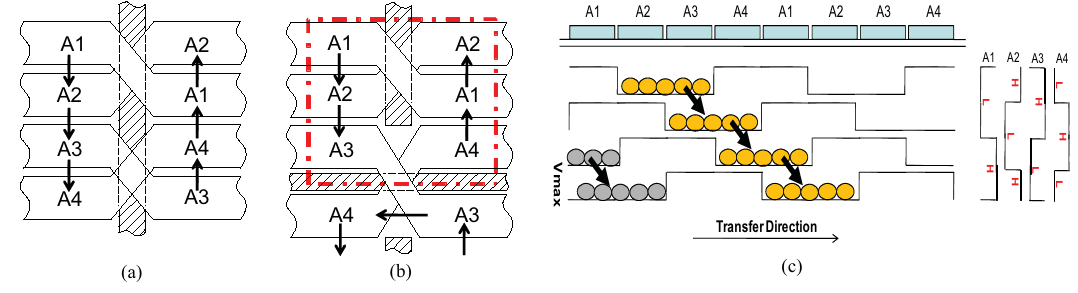
Figure 8. Scheme for direction change for four-phase transfer: (a) Twisted electrodes for opposite direction four-phase transfer; (b) Horizontal direction change; (c) Four-phase transfer scheme with 2-by-2 duty cycle.